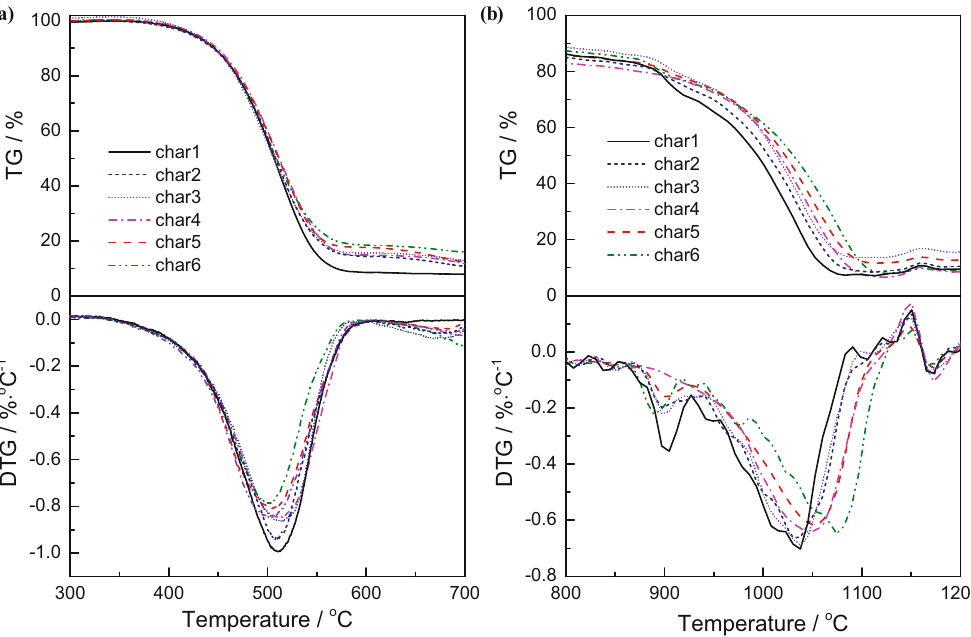
Figure 2: TG – DTG curves of combustion and gasi fi cation processes of semi - coke samples prepared under di ff erent pyrolytic atmospheres. ( a ) Air atmosphere; ( b ) CO 2